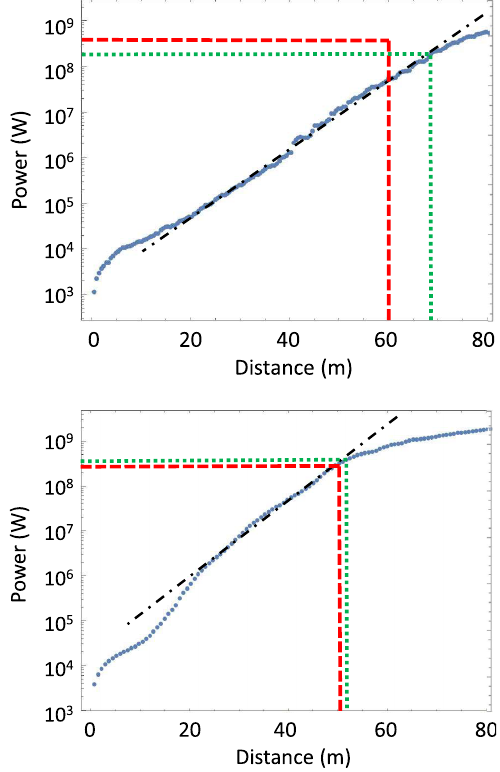
FIG. 5. SASE FEL peak power along the TGU in single pass mode, from GENESIS runs at the wavelength of 13 nm (top) and 4 nm (bottom). Each curve is the average of an ensemble of runs starting from random noise seed. Electron beam and FEL parameters are in Tables I and III. The dotted dashed black line guides the eye along the exponential power growth. The dotted green lines (dashed red lines) point to the end of the exponential growth in GENESIS (saturation in beam